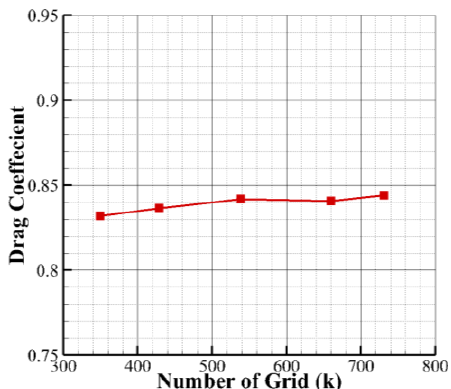
Figure 7. The drag coefficient obtained by using different density grids.